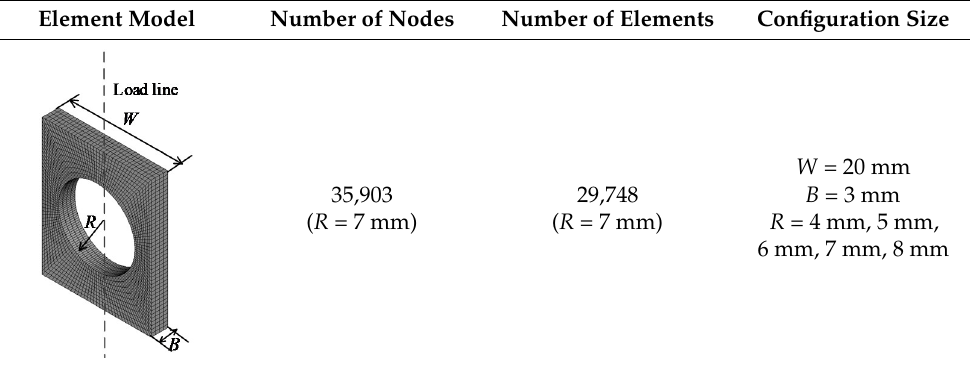
Table 1. Finite element models of the CHS specimen. Element Model